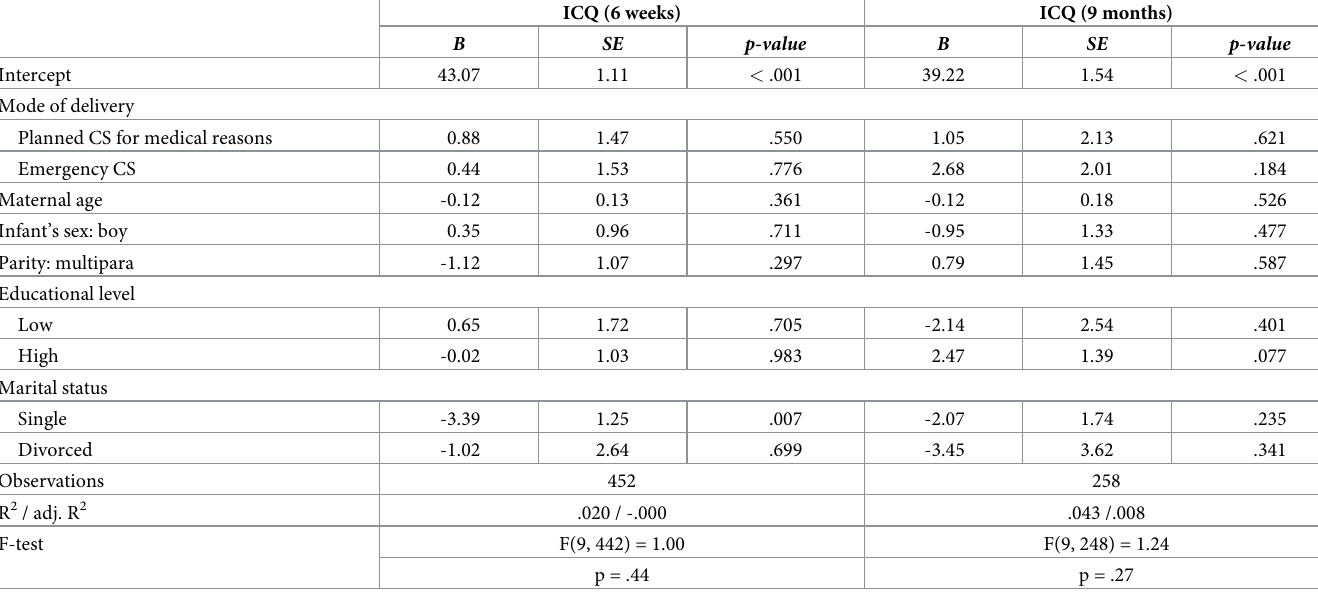
Table 2. Association between the mode of delivery and infant temperament—Adjusted for sociodemographic factors, parity and infant’s